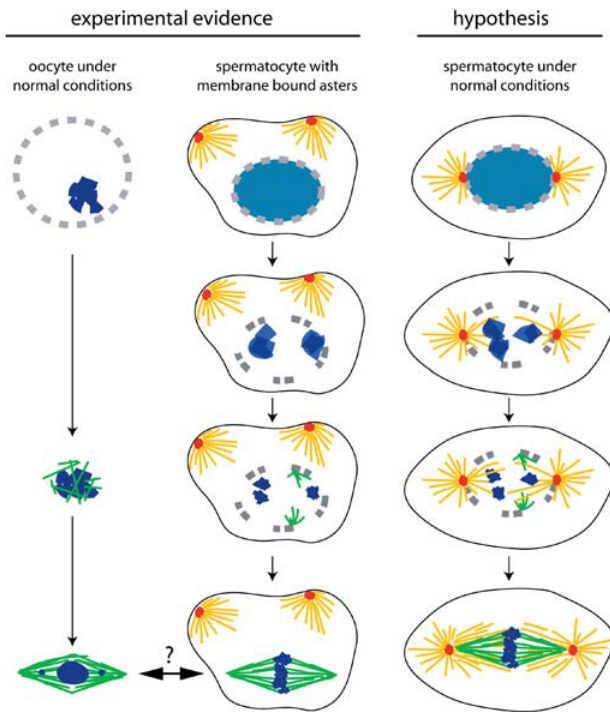
Figure 7. Noncentrosomal Microtubules and Spindle Assembly (Central column) Spindle assembly in Drosophila spermatocytes with membrane-bound centrosomes. At the time of NEB, the chromatin (pale blue) starts to condense, and the membrane-bound centrosomes (red) organise asters (yellow) at a significant distance from the nuclear region. Around 12 min after NEB, the first noncentrosomal micro- tubules (green) start to nucleate near the remnants of the NE (grey), as the chromosomes achieve full condensation (dark blue). These microtubules then bundle, associate with the chromosomes, and eventually end up organised into a bipolar anastral array whose shape is reminiscent of the female meiotic spindle. (Left column) Spindle assembly in wild-type Drosophila oocytes (Theurkauf and Hawley 1992; Matthies et al. 1996). NEB starts at the beginning of stage 13 of oocyte development. At this stage, the oocyte does not contain centrosomes and the chromosomes (karyosome) are tightly condensed (dark blue). Microtubules (green) appear 11–15 min after NEB within the nuclear region in association with the karyosome. These microtubules form bundles and are sorted around the chromatin into a bipolar spindle. Evidence suggests that ER components may be required for spindle assembly in these cells (Kramer and Hawley 2003). At metaphase I, recombined bivalents are aligned at the spindle equator, while those that have not recombined are found closer to the spindle poles. Meiosis remains arrested at this point (stage 14) until oocyte activation. Despite the obvious morphological similitude, the equivalence between these and the anastral spindles organised in spermatocytes with membrane-bound centrosomes is unclear. (Right column) Hypothesis regarding the contribution of centroso- mal and noncentrosomal microtubules to spindle assembly during meiosis I in wild-type Drosophila spermatocytes. Before NEB, the centrosomes are located at opposite positions near the nucleus. Shortly after NEB, astral microtubules enter the nuclear region and make the first contact with the condensing chromatin. No evidence of noncentrosomal microtubule polymerisation near the nuclear region at this stage has been found yet. Once chromosomes are fully condensed, microtubule bundles of centrosomal origin (yellow) connecting centrosomes to chromosomes already exist. At this stage, noncentrosomal microtubules (green) start to polymerise in associ- ation with the remnants of the NE. These microtubules form bundles that interact with the chromosomes and intermingle with the microtubules of centrosomal origin. The fully mature spindle in these cells would therefore contain a spindle-shaped structure made of microtubules of noncentrosomal origin (green) embedded in another spindle-shape array made of two overlapping asters